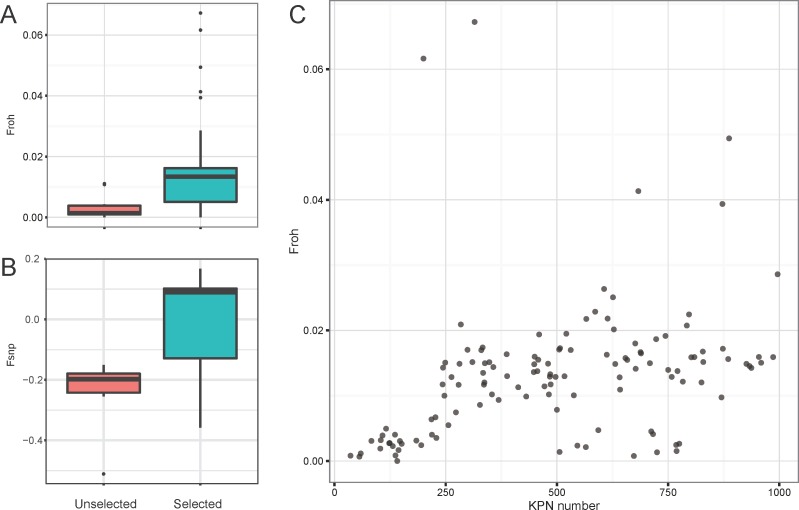
Individual genome-wide autozygosities (Froh).Comparison of (A) Froh and (B) Fsnp between selected (n = 126) and unselected (n = 10) cattle populations. Selected and unselected cattle populations were significantly different in both Froh and Fsnp (Wilcoxon rank sum test, p-value = 9.704e-05 and 2.979e-04, respectively). (C) Change of Froh during the past ~20 years. KPN number was used instead of cattle birth year.